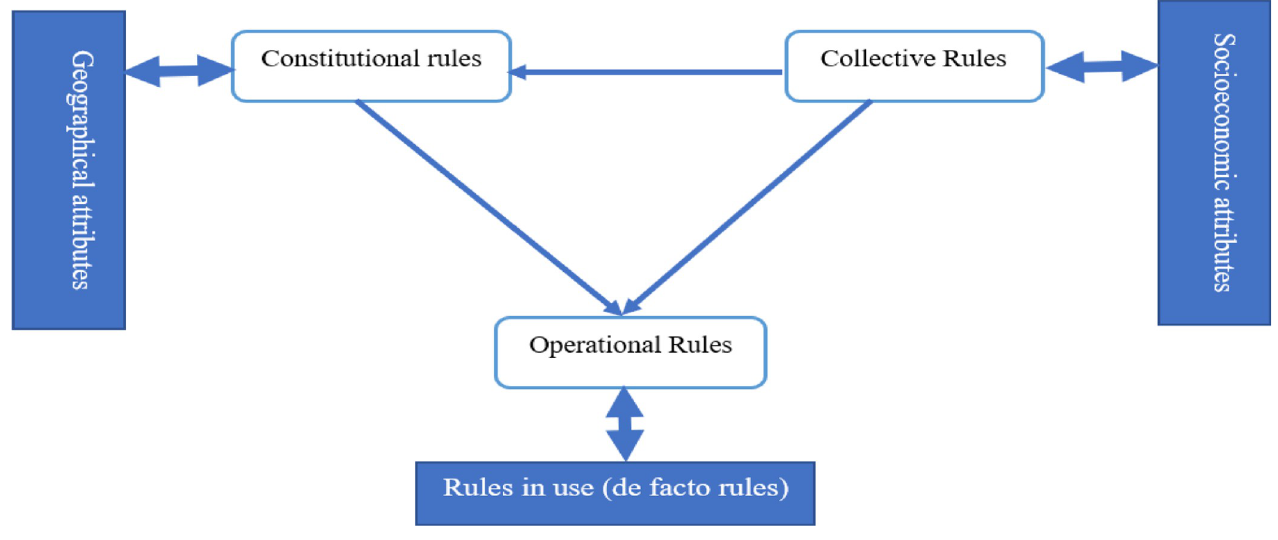
Fig 1. Conceptual framework of the